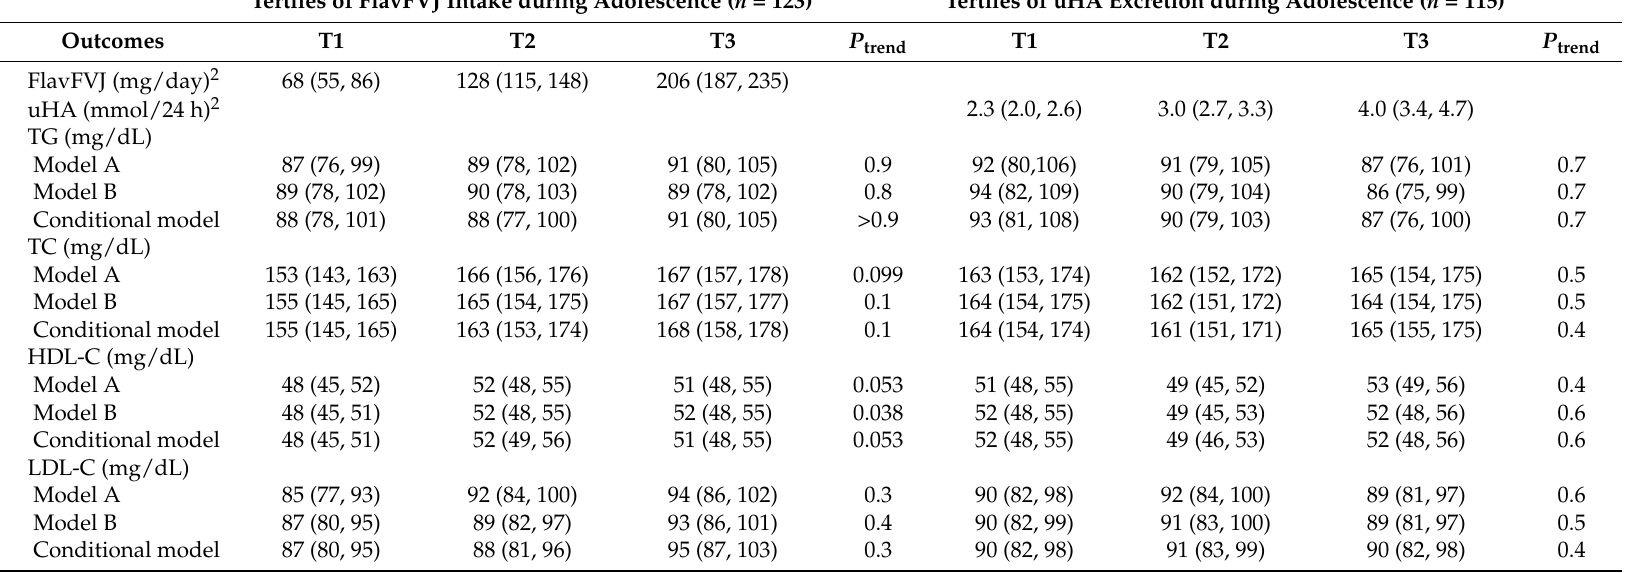
Table 2. Prospective associations of dietary flavonoid intake from fruit and vegetables including juices (FlavFVJ) and urinary hippuric acid (uHA) excretion during adolescence with serum lipid levels in early adulthood among males 1 . Tertiles of FlavFVJ Intake during Adolescence ( n = 123) Tertiles of uHA Excretion during Adolescence ( n =